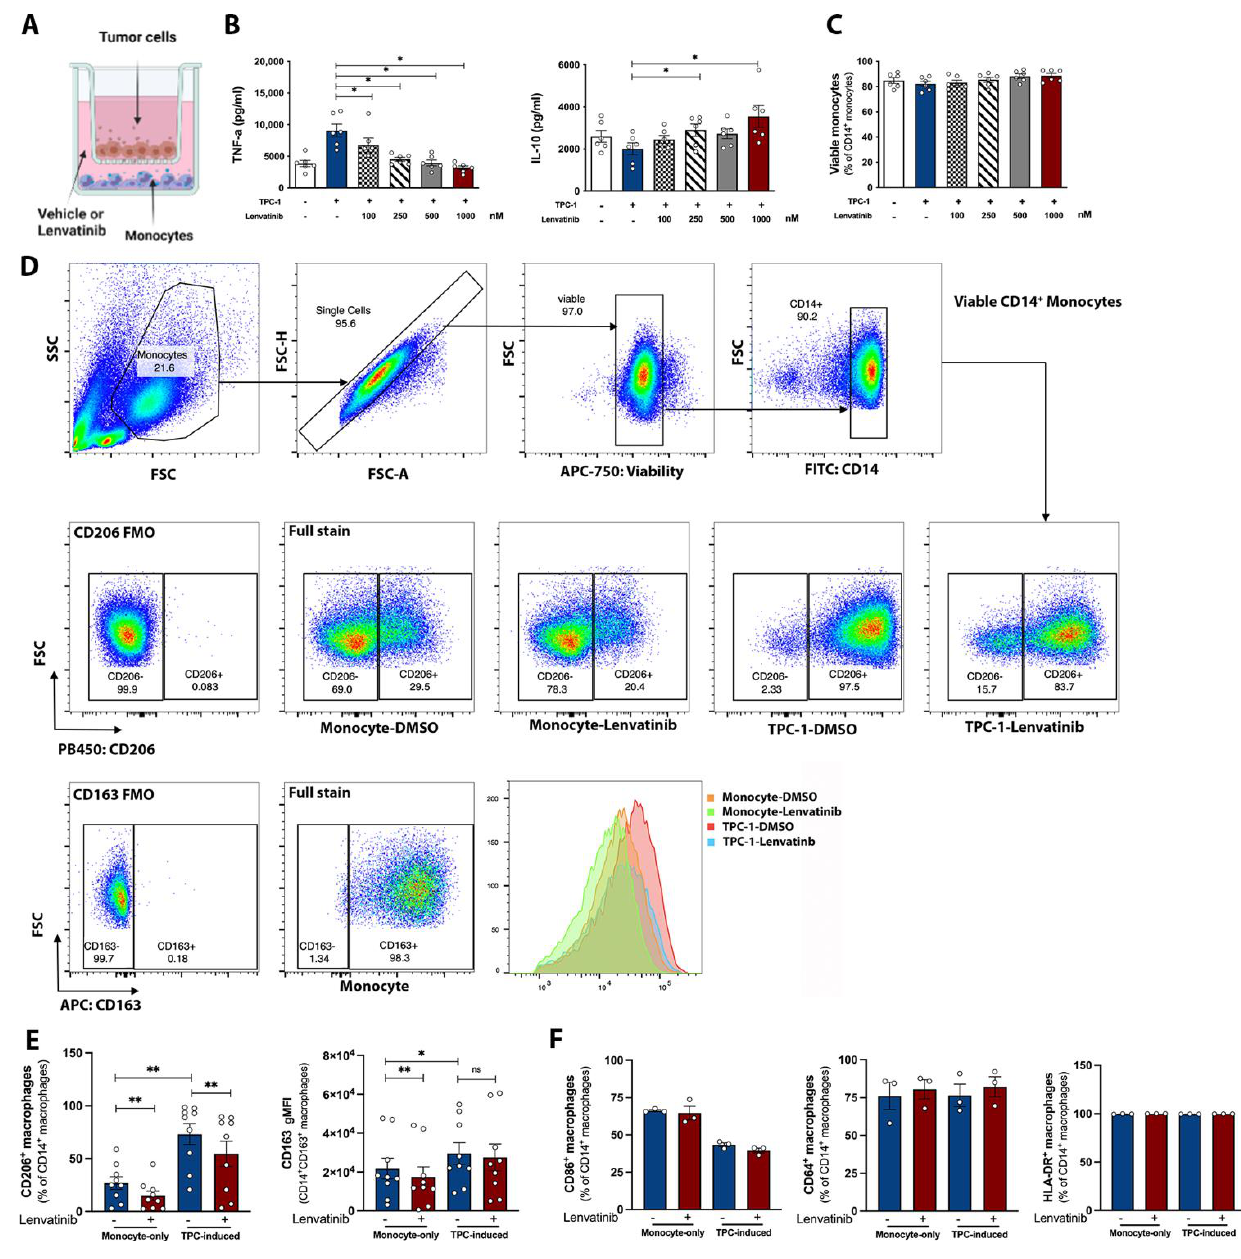
Figure 2. Lenvatinib interferes with monocytes' functional rewiring in co-culture experiments. ( A ) Schematic diagram of the co-culture experiments. ( B ) Cytokine secretion from TPC-1 induced monocytes treated with indicated concentrations of Lenvatinib; monocytes cultured in RPMI were included as the baseline control, n = 6. ( C ) Viability of monocytes after 24h exposure to Lenvatinib; percentage of viable CD14 + cells were gated for statistical analysis, n = 6. ( D ) Expression of M2 markers in TPC-1-induced monocytes. The upper panel shows the gating strategy to identify the viable CD14 + monocytes. Identification of CD206 + and CD163 + subsets within viable CD14 + monocytes was based on FMO controls. The lower panel shows the representative dot plot and histogram from one donor. ( E ) Quantification of the percentage of CD206 + subsets within CD14 + monocytes and fluorescence intensity of CD163 signal on CD14 + CD163 + monocytes, n = 6. (F) Expression of M1 markers (CD86, CD64, and HLA-DR), n = 3. The bar graphs indicate mean ± SME; each dot represents one healthy donor. * p < 0.05, ** p < 0.01 by nonparametric Wilcoxon matched-pair tests. FMO, fluorescence minus one control; gMFI, geometric mean fluorescence intensity.